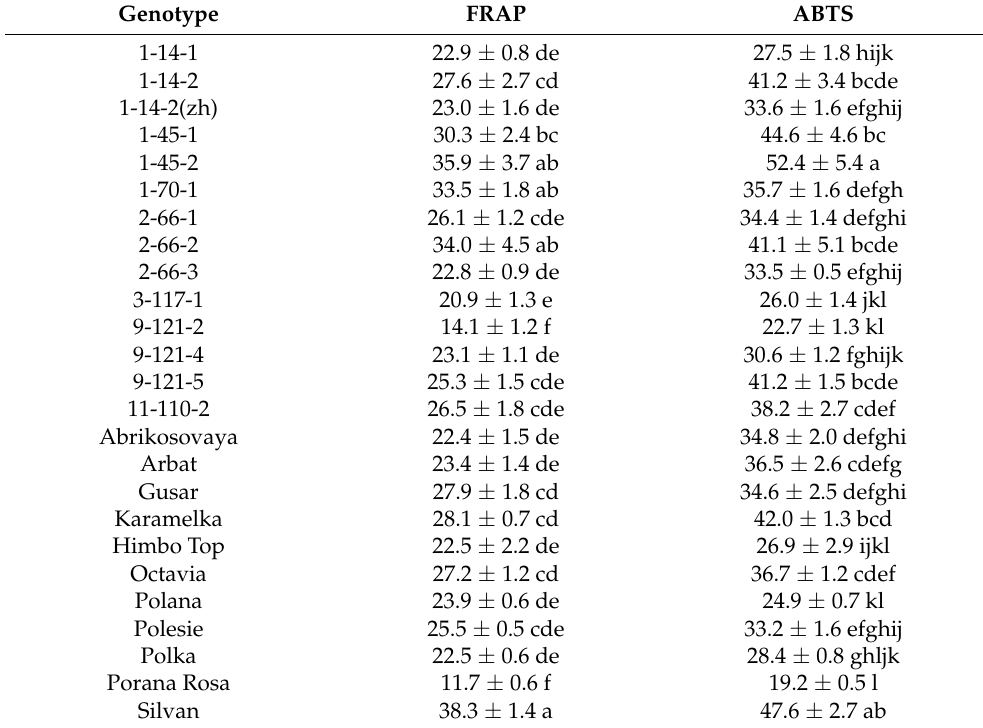
Table 3. Antioxidant activity (micromol TE/g FW) of raspberry berries.